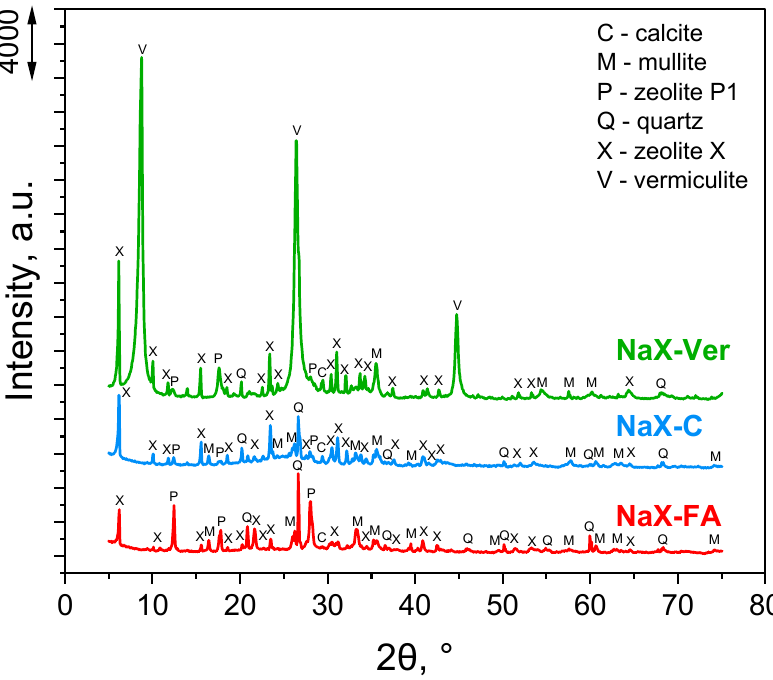
Figure 1. XRD patterns of investigated materials.